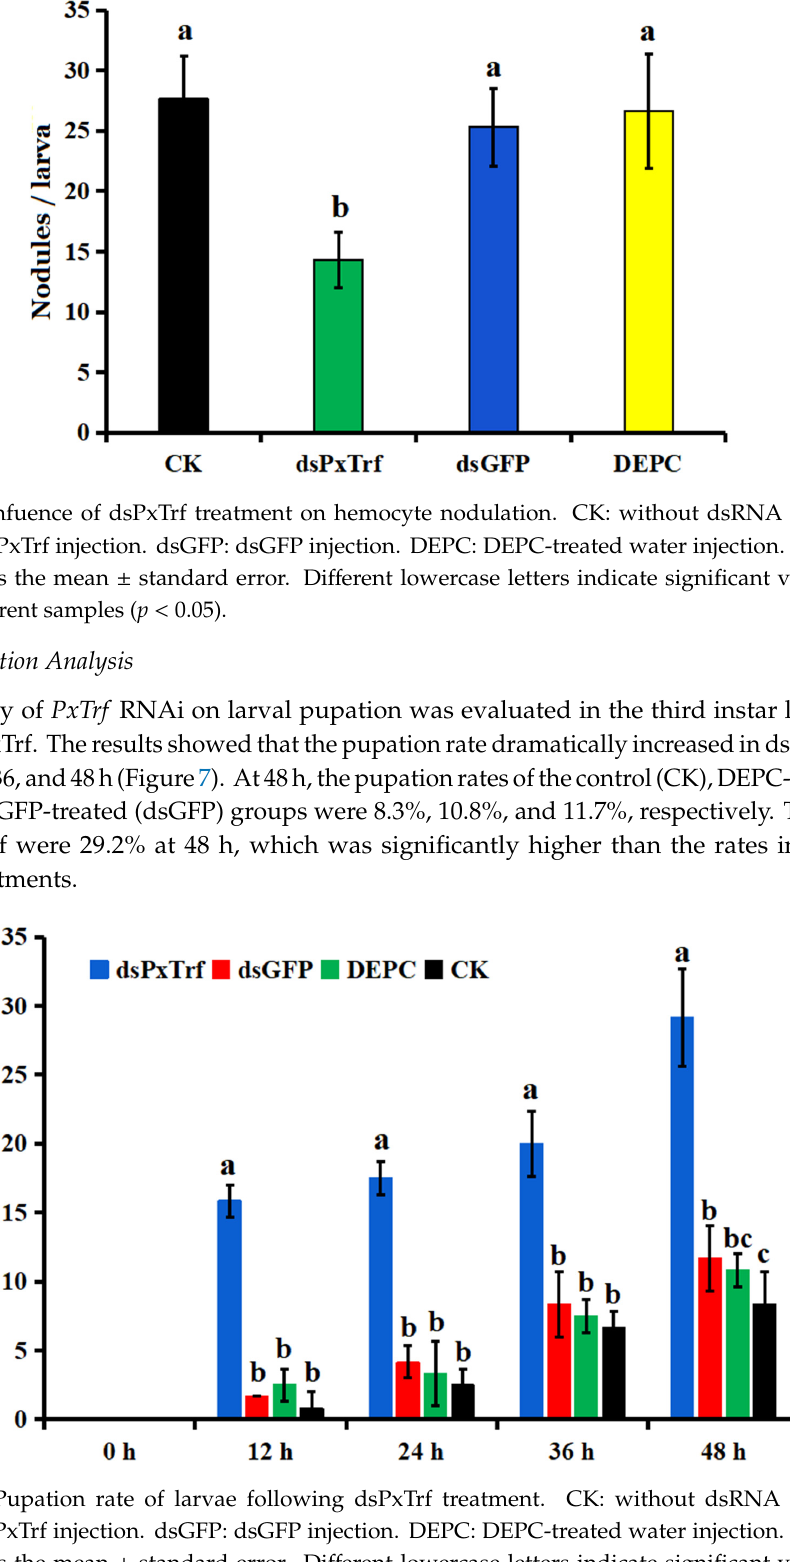
infection. p -values are presented only for the treatments with significant difference compared with